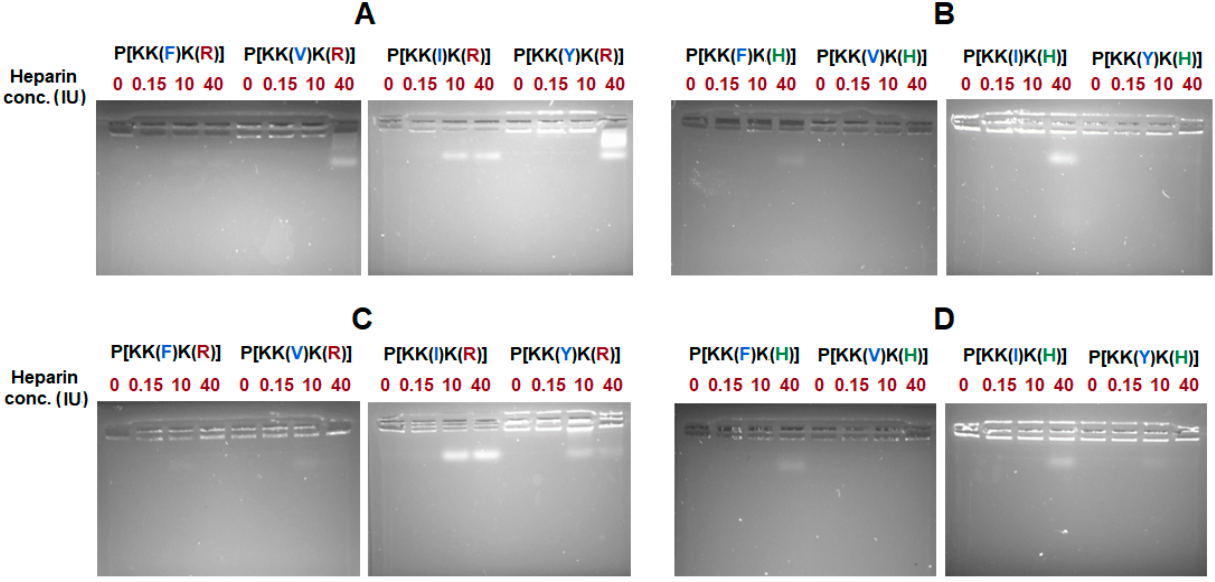
Figure 8. Heparin displacement test (agarose gel electrophoresis): ( A ) PP@oligo-dT-dA based on Arg-containing polypeptides; ( B ) PP@oligo-dT-dA based on His-containing polypeptides; ( C ) PP@PTX+oligo-dT-dA based on Arg-containing polypeptides; ( D ) PP@PTX+oligo-dT-dA based on His-containing polypeptides. The concentration of heparin was varied from 0 to 40 IU. In the case of Arg-containing polypeptides besides P[KK(I)K(R)], the polypeptide/oligo-dT-dA ratio was 12; for P[KK(I)K(R)], it was 16. In the case of His-containing polypeptides besides P[KK(I)K(H)], the polypeptide/oligo-dT-dA ratio was 16; for P[KK(I)K(H)], it was